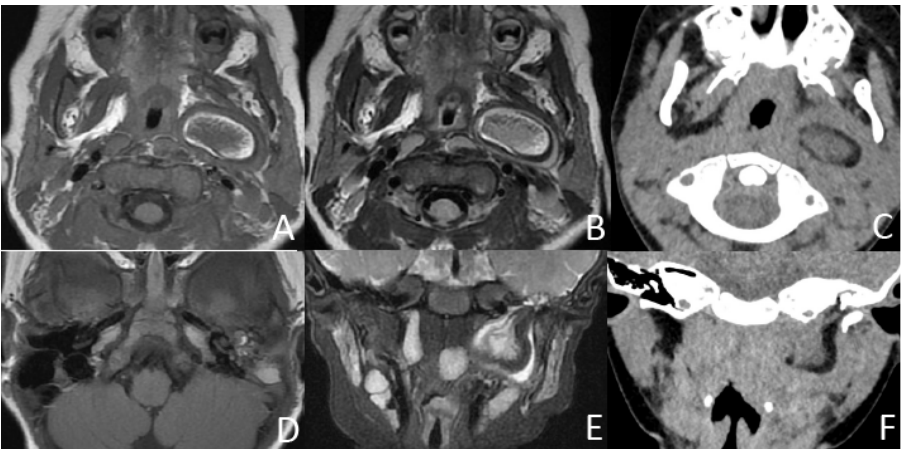
Figure 4. MRI (conducted at 11 months) and CT (conducted at 2 years and 7 months) of a girl who failed newborn hearing screening of the left ear, presenting with left otopyorrhea from 2 years old. ( A , B ) Axial T1-weighted, T2-weighted MRI show a multilayered circumferential mass in the left parapharyngeal space that is soft tissue, lipid, fibrous capsule, and soft tissue intense from inside to outside. ( C ) Axial CT shows a 3-layered circumferential mass that is soft tissue dense, fat dense, and soft tissue dense from inside to outside. ( D ) Axial T1-weighted MRI shows an irregular hyperintense and isointense mass in the left middle ear. ( E , F ) Coronal T2W-SPIR MRI and CT show the pear-like multilayered circumferential mass in the left multilayered circumferential mass with the pedicle extending to the left middle ear and the bone defect of the inferior wall of the external auditory canal and mastoid process.